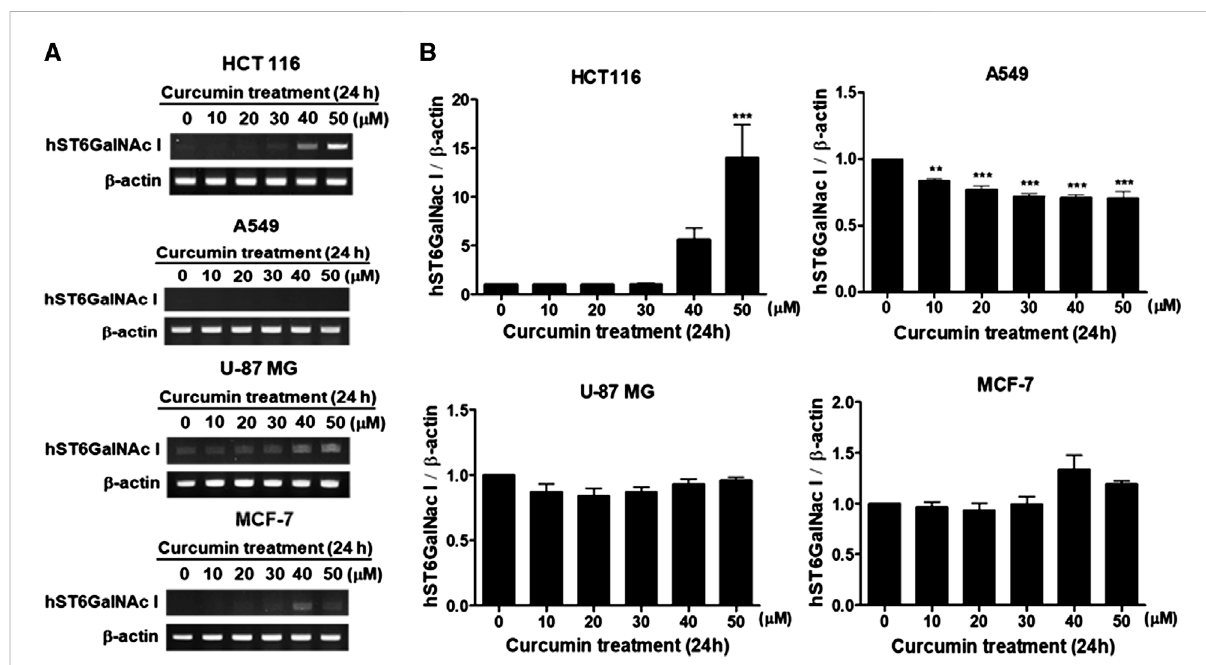
FIGURE 1 Effect of curcumin on hST6GalNAc I gene expression in HCT116, A549, U-87 MG and MCF-7 cells. After cells were treated for 24 h at different concentrations(0,10,20, 30,40,50 μ M) ofcurcumin, mRNAlevels ofhST6GalNAcIwereanalyzed byRT-PCR usingtheextracted totalRNAs (A) . β - actin mRNA was also analyzed as an internal standard. The densitometric intensity of hST6GalNAc I band was shown as percentages of the control (0 μ M)inthepanelbelow (B) .Resultsarepresentedasthemean±SEMforthreeindependentexperiments.*** p < 0.001comparedwithcontrol cells untreated with